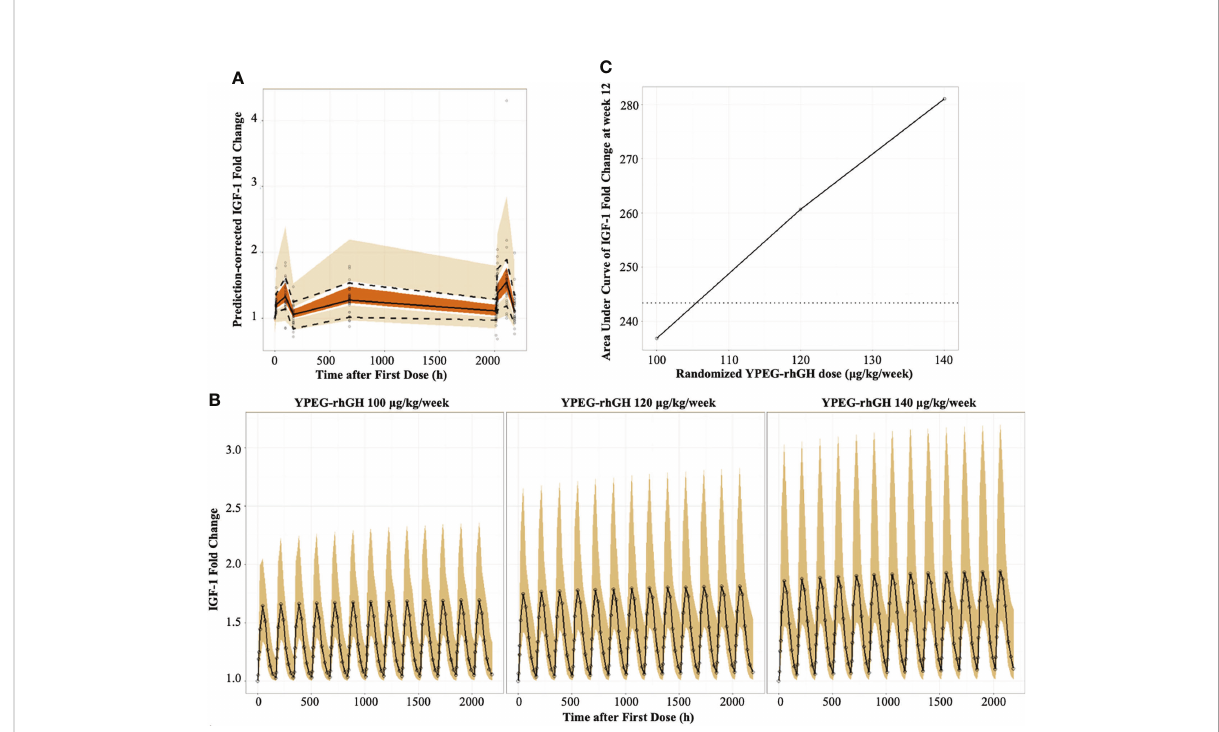
FIGURE 2 Model-derived PD pro fi les of YPEG-rhGH (A) , Prediction-corrected visual predictive checks (pcVPC) of IGF-1 fold change (IGF-1 FC). The hollow dots indicated the prediction-corrected IGF-1 FC. The top dashed line, the middle solid line and the bottom dashed line indicated 10th percentile, median and 90th percentile of prediction-corrected IGF-1 FC. The top, middle and bottom area indicated the 95% con fi dence interval of each line. (B) , model-derived PK/PD pro fi les of IGF-1FC. The hollow dots and solid line indicated the medium of IGF-1 FC. The shallow area indicated the 5% and 95% con fi dence intervals predicted by the model. (C) , the model-derived AUC-dose relationship of IGF-1 FC in GHD children. The black solid line and hollow dots indicated the geometric means of AUC IGF-1 FC with YPEG-rhGH. The dashed line indicated the geometric means of AUC IGF-1 FC with daily